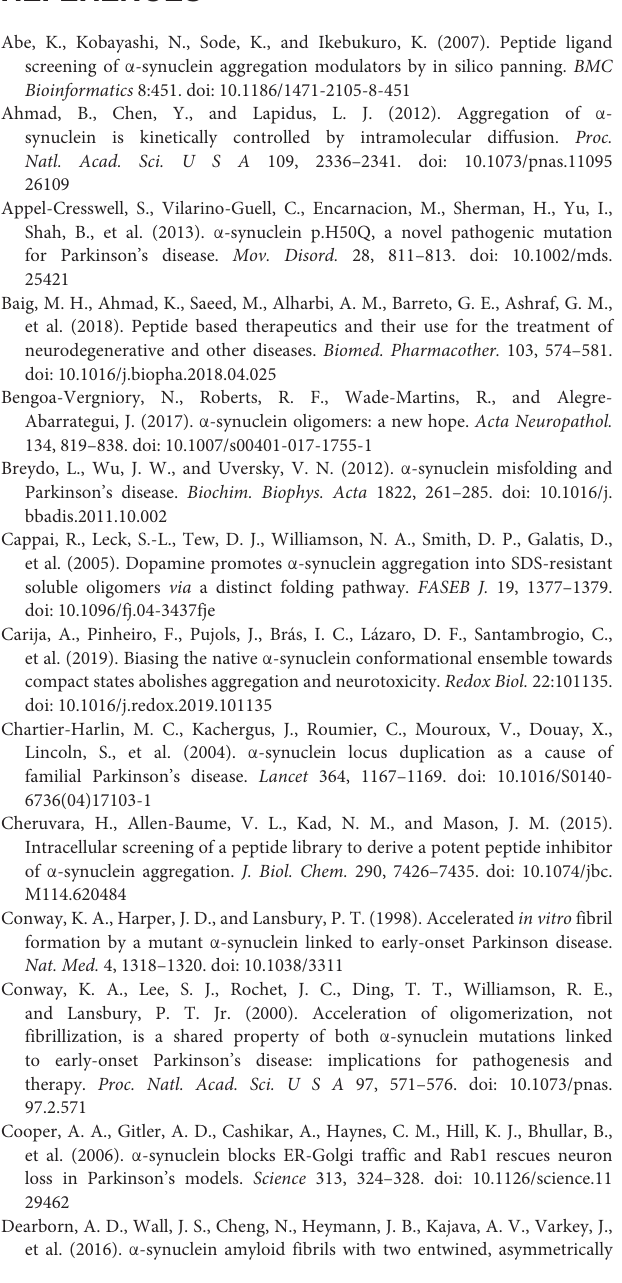
SUPPLEMENTARY FIGURE 6 | Secondary structure predictions of the indicated peptides. PEP FOLD 3 tool was used for predicting peptide structures from amino acid sequences. (A) Peptide constructs with N-terminal GB1-scaffold expressed in yeast. K50 and K117 contain also the C-terminal scaffold sequence, as indicated in Table 3 . (B) Predicted structure of the synthetic peptides